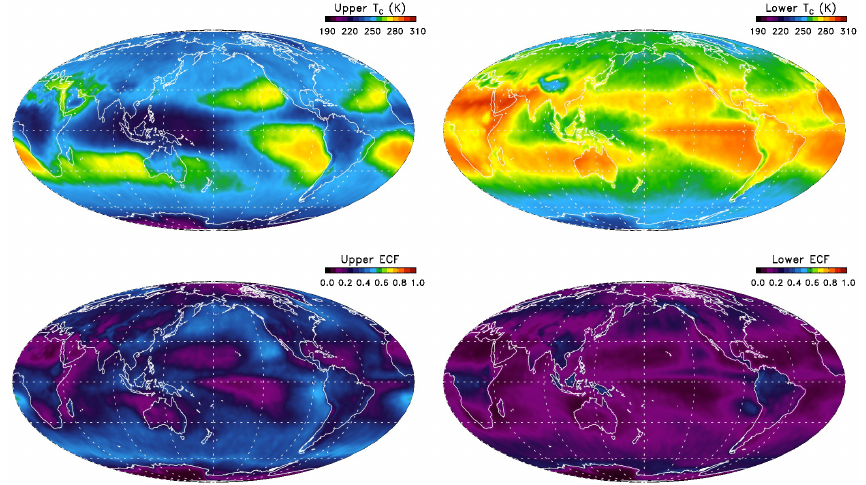
Fig. 2. The AIRS standard L2 cloud top temperature T C (upper row) and effective cloud fraction ECF (lower row) for the upper layer (left column) and lower layer (right column) for 2007.